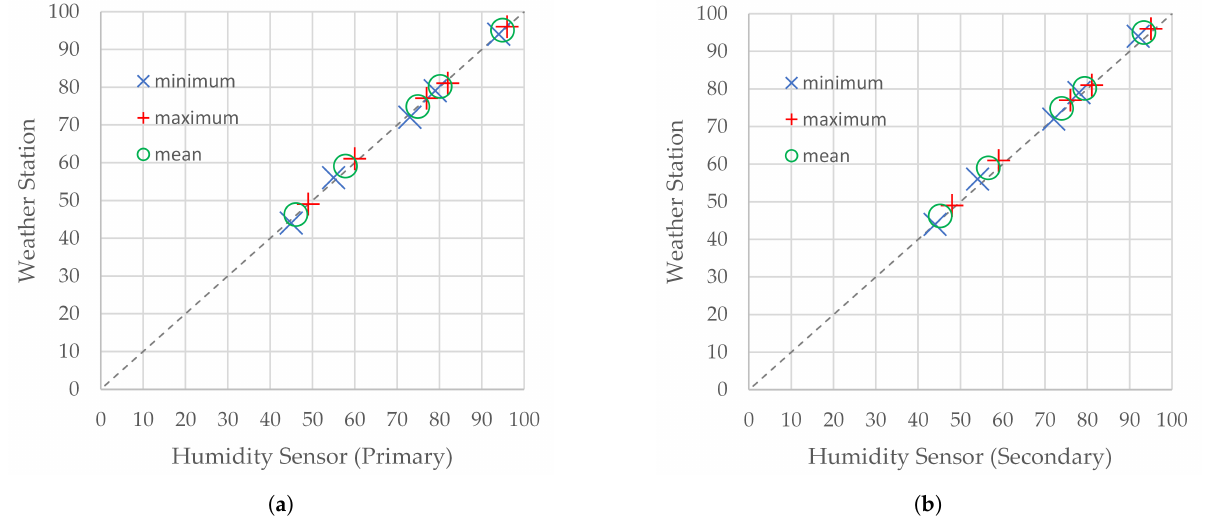
Figure 6. Scatter plots for statistics of humidity measured by the SBS-WS-400 reference weather station and ( a ) the primary humidity sensor of the flying weather station and ( b ) the secondary